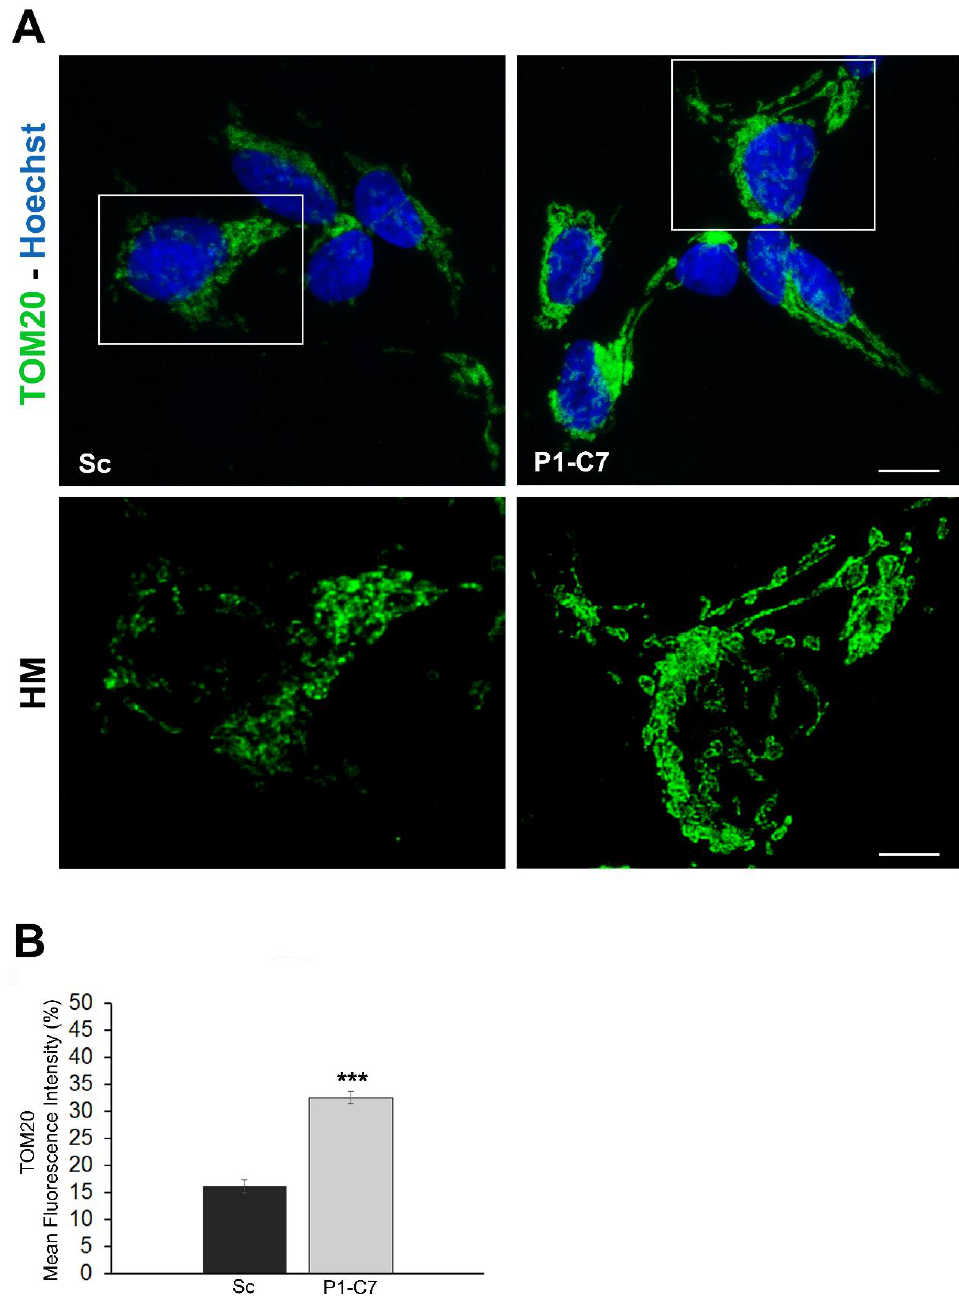
Figure 6. ( A ) Upper panel: Confocal microscopy images (Z-reconstruction) of TOM20 (green) immunofluorescence in Scramble (Sc) and silenced Pin1 (P1-C7) cells showing changes in mitochondrial amount and distribution. Nuclei are counterstained with Hoechst 33342 (blue). Bar: 10 µ m. Lower panel: High magnification (HM) of deconvolved z-stack images highlighted in insets , in which a higher mitochondria amount, particularly in perinuclear area and in cellular extensions, was observed in silenced Pin1 cells. Bar: 5 µ m. ( B ) Mean fluorescence intensity of TOM20 in Scramble (Sc) and silenced Pin1 (P1-C7) cells. Data are presented as the mean ± SEM (*** p > 0.001). 2.1.4. Liraglutide Enhances Cell Viability, Anti-Apoptotic Signals and Reduced ROS in Cells Treated with MG Cell viability was tested in presence of di ff erent concentrations of MG for 24 h (Figure S1C). Viability of parental cells was determined by the MTT assay following 5 h starvation and 600 uM